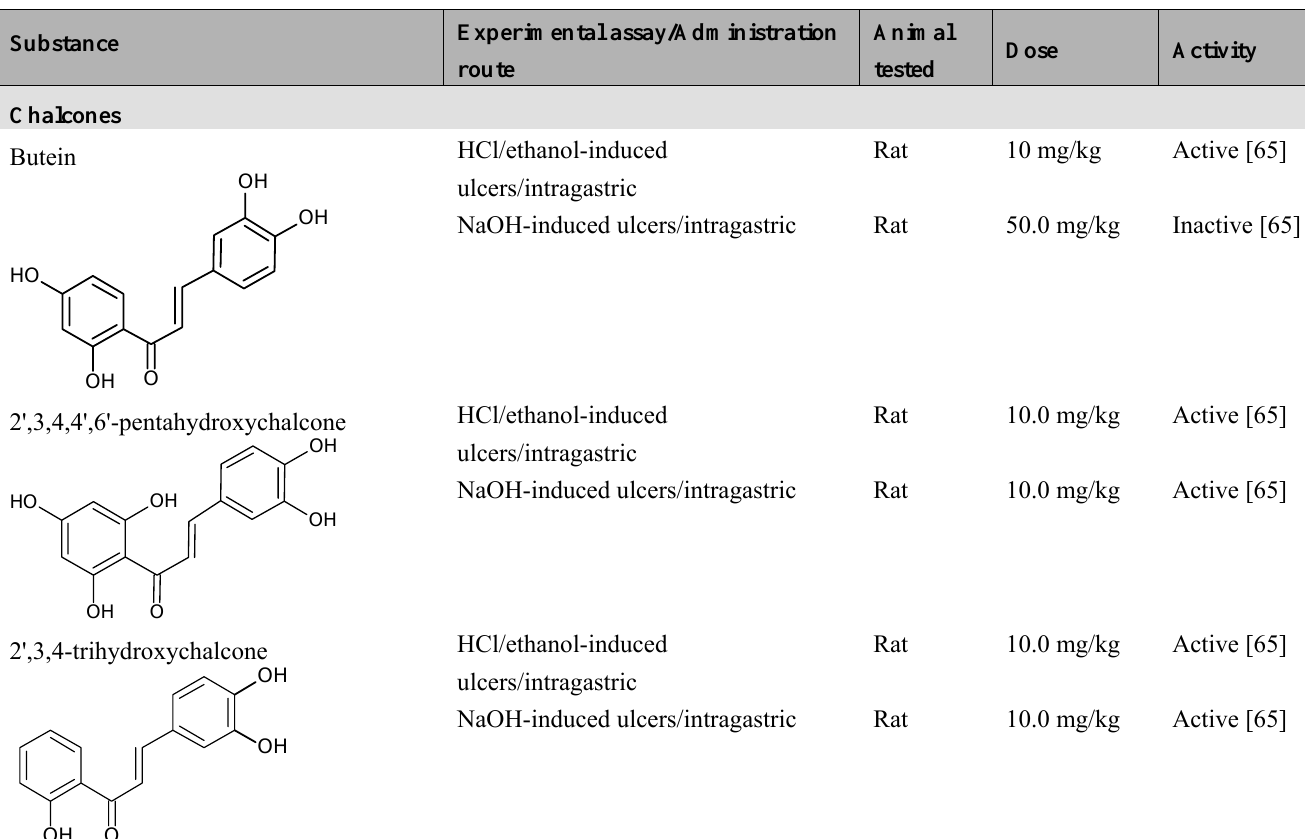
Table 1 . Flavonoids with gastroprotective